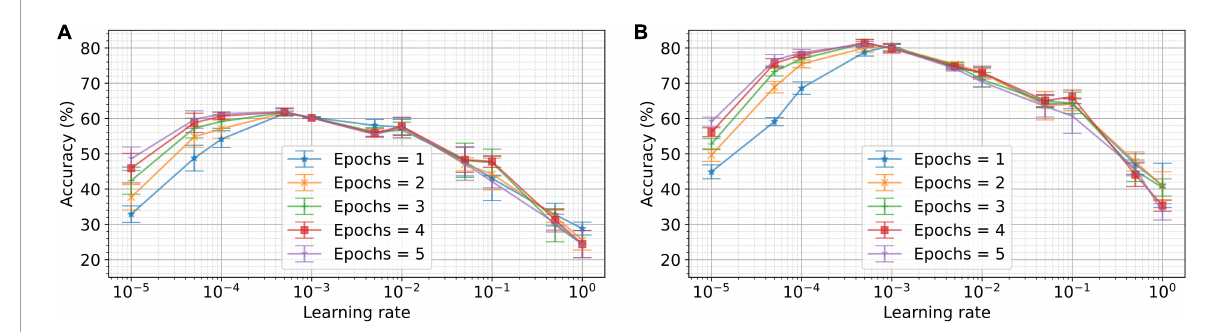
FIGURE6 Dependence of the performance on learning rate and number of epochs for different network sizes. In (A) , a network with 10 output neurons was trained on the MNIST dataset for different numbers of epochs and learning rates. Networks with learning rates ranging from 10 − 5 to 1 were trained for the number of epochs ranging from 1 to 5. Each experiment was conducted for five different initial conditions. The mean accuracy for five trials is plotted in the figure, with the error bar indicating the standard deviation. In (B) , the experiments are repeated for 50 output neurons. As depicted, the optimum learning rate for a single epoch and 10 neurons is 5 × 10 − 4 . Whereas, for 50 output neurons, the optimum learning rate for a single epoch is 10 − 3